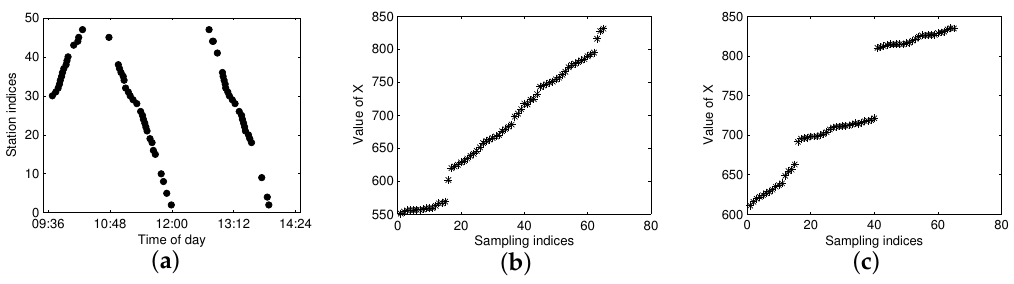
Figure 10. Comparison of the separable performance of X constructed by forward and backward clustering of G ( m , l ) with wrong traveling direction trajectories. ( a ) Arrival events; ( b ) constructed X for forward clustering; ( c ) constructed X for backward clustering.